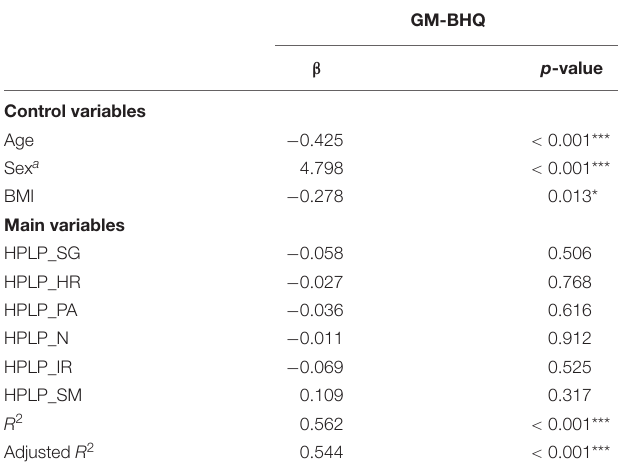
TABLE 4 | Multiple regression analysis of the HPLP factors on GM-BHQ.